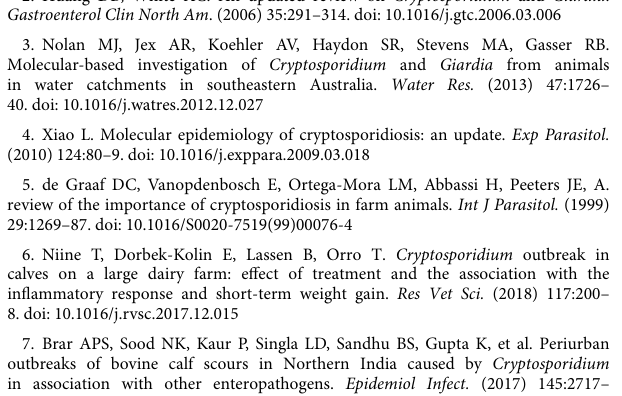
SUPPLEMENTARYFIGURE1 Nested PCR targeting SSU rRNA and gp60 genes. Amplified PCR products were sepa-rated by electrophoresis on a 1.5% agarose gel and visual-ized after staining with ethidium bromide. Lane 1: DNA ladder (1kb); Lanes 2–5: PCR amplicons for SSU rRNA (830 bp); Lanes 6 and 7: PCR amplicons for gp60 (467 bp); and Lane 8: negative